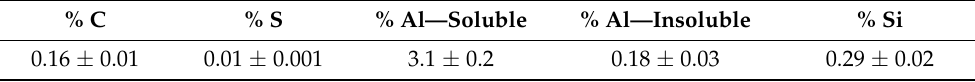
Table 4. Average values of the selected elements in the recycled FeTi-cored wire (wt. %). % C % S % Al—Soluble % Al—Insoluble % Si 0.16 ± 0.01 0.01 ± 0.001 3.1 ± 0.2 0.18 ± 0.03 0.29 ±